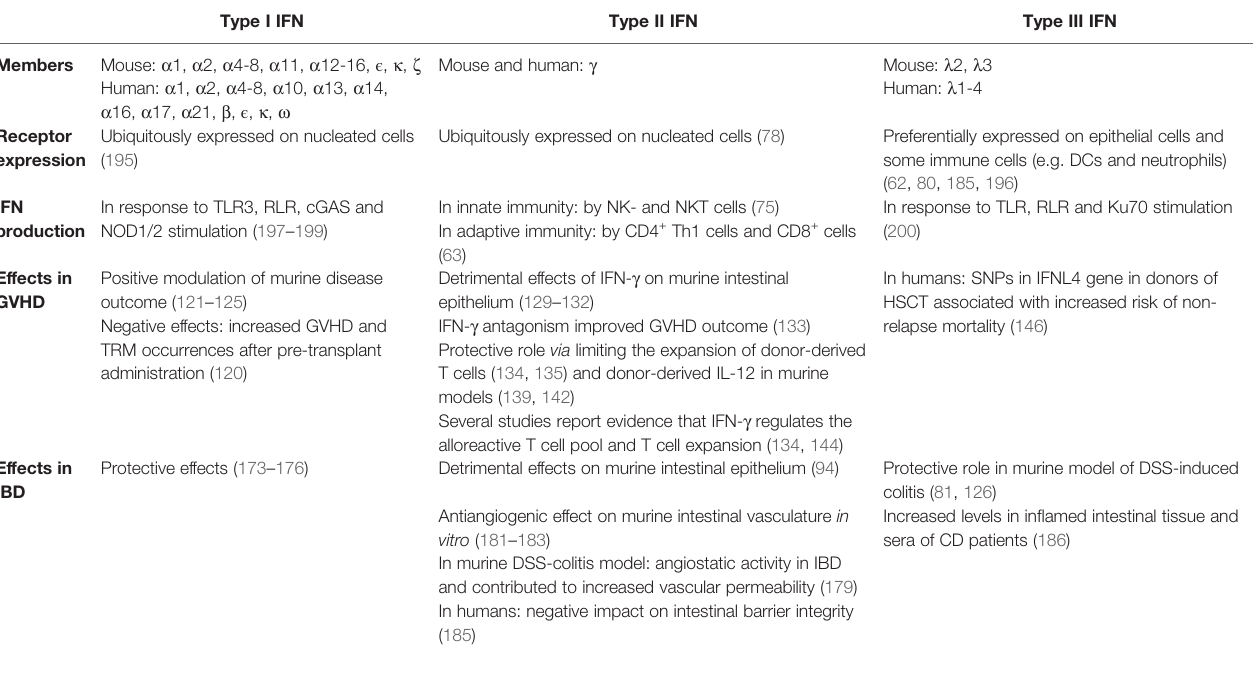
TABLE 1 | Overview about Type I, -II and -III IFNs and their role in GVHD and IBD pathogenesis. Type I